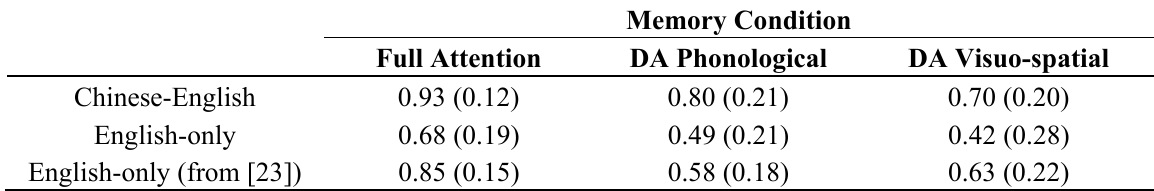
Table 1. Mean Accuracy in Chinese-English and English-only Groups Retrieving Chinese Characters, and English words in an English-only group (from Fernandes and Guild, 2009 [23]), in Each Memory Condition (Standard Deviations in